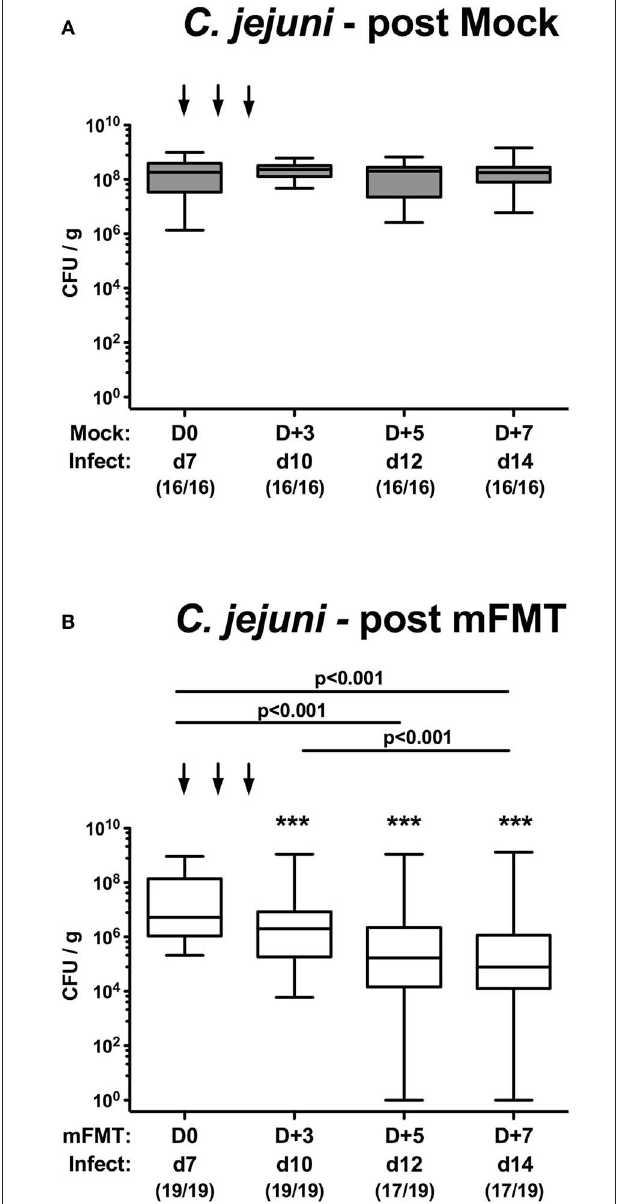
FIGURE 2 | Kinetic survey of fecal C. jejuni shedding following murine fecal microbiota transplantation of infected mice harboring a human gut microbiota. Mice with a human gut microbiota were perorally infected with C. jejuni on day (d) 0 and d1 (Infect) and subjected to (A) vehicle (mock) treatment or to (B) murine fecal microbiota transplantation (mFMT) on d7, d8, and d9 post-infection (arrows; D0, D + 1, D + 2). Immediately before and after mFMT fecal samples were taken at defined time points as indicated to assess intestinal pathogenic loads by culture (expressed as colony forming units per gram, CFU/g). Box plots represent the 75th and 25th percentiles of medians (black bar inside the boxes). The total range, significance levels ( p -values) determined by the Kruskal-Wallis test and Dunn’s post-correction and the numbers of C. jejuni positive mice out of the total number of animals (in parentheses) are given. Data were pooled from four independent experiments. *** p < 0.001 comparing bacterial loads in mock vs. mFMT treated mice at identical time points (Mann Whitney U